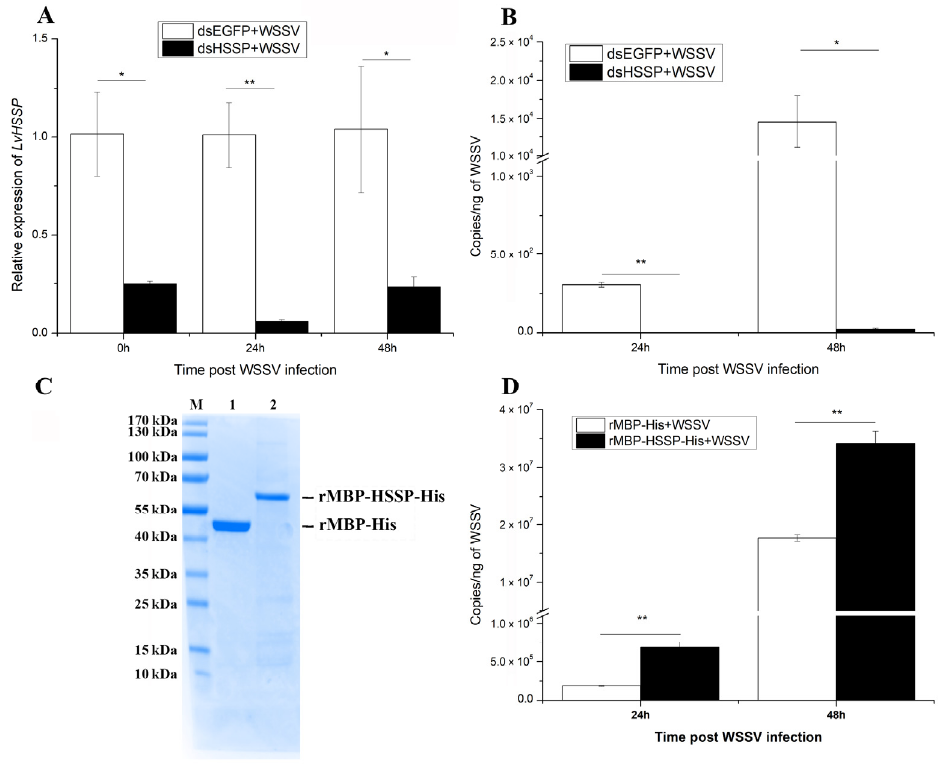
Figure 6. LvHSSP is beneficial for WSSV infection in shrimp. ( A ) Inhibition efficiency of LvHSSP dsRNA. Expression levels of LvHSSP in hemocytes of dsHSSP + WSSV and control groups after 0, 24, and 48 h post-WSSV infection. ( B ) Amount of WSSV particles in different groups at different hours after silencing of LvHSSP and WSSV infection. ( C ) Expression and purification of recombinant of rMBP-HSSP-His. Lane M, protein marker; lane 1, purified control protein rMBP-His; lane 2, purified recombinant protein rMBP-HSSP-His. ( D ) Amount of WSSV particles in different groups at different hours after infection of the incubated mixture of recombinant protein and WSSV. Stars (*) indicate significant difference ( p < 0.05) and (**) indicate extremely significant difference ( p < 0.01) in the gene expression levels between the two treatments. All assays described above were biologically repeated at least three times.